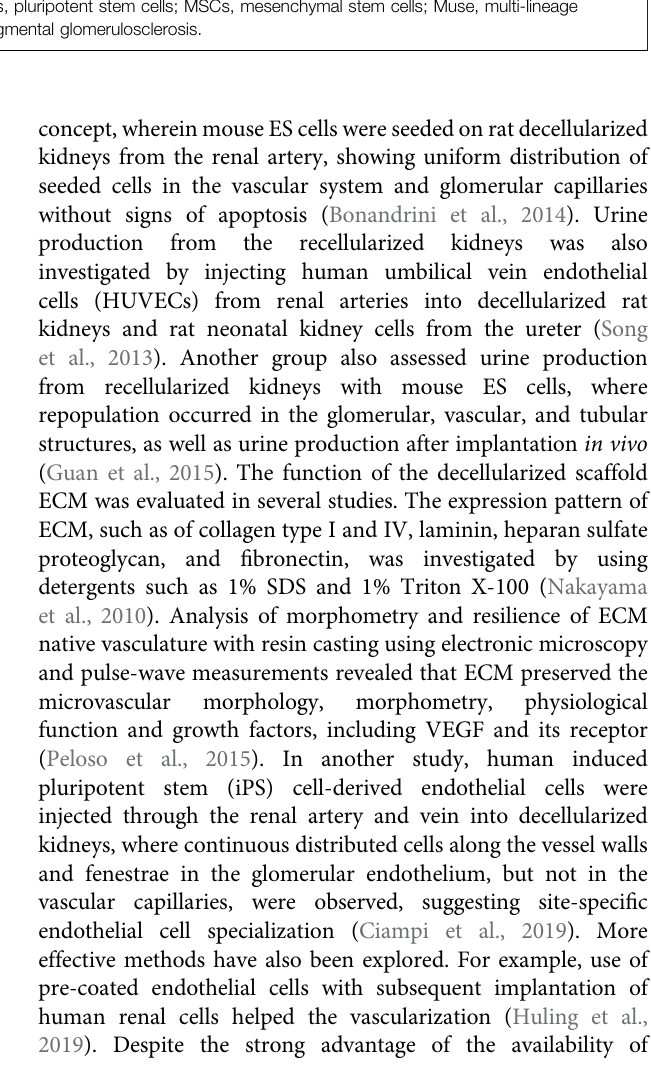
Frontiers in Cell and Developmental Biology |